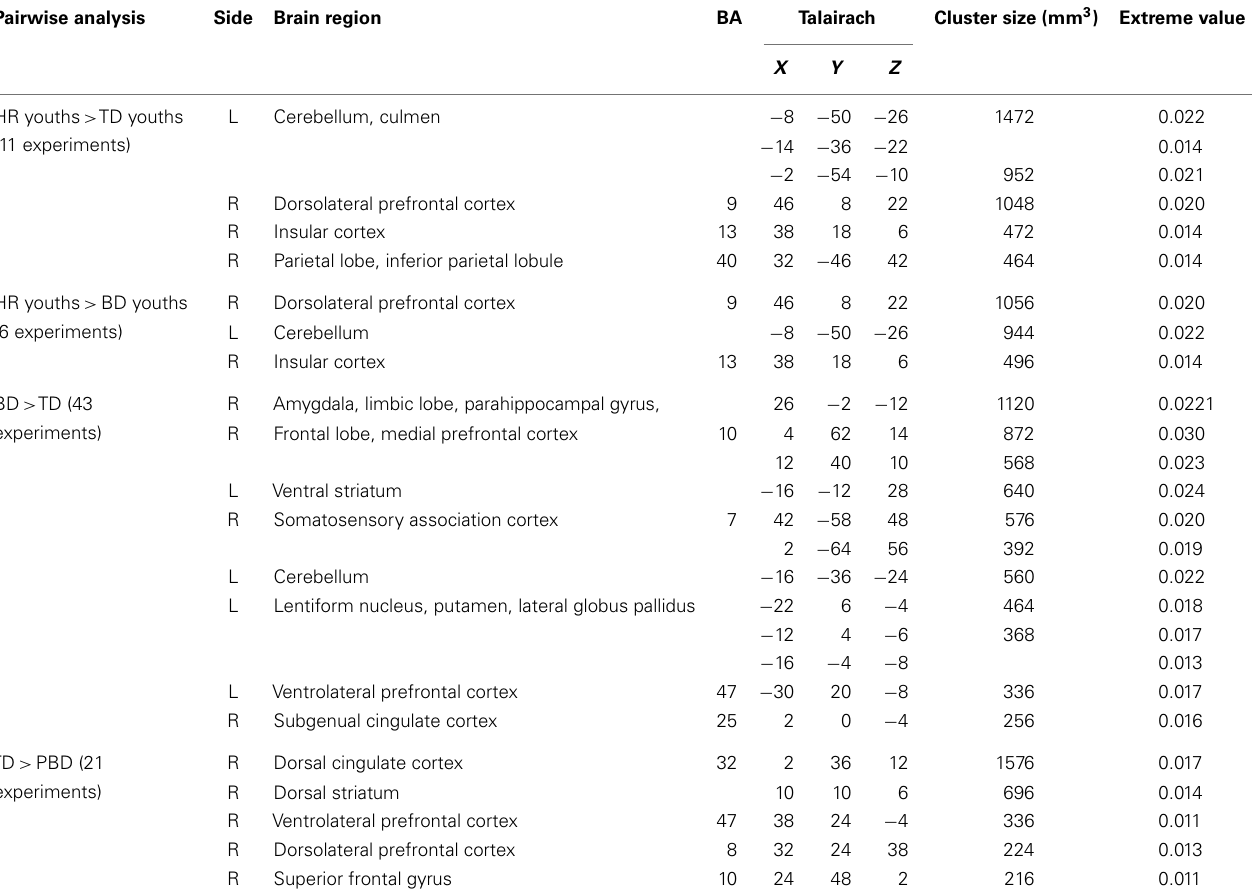
Table 2 |Activation likelihood estimation (ALE) meta-analysis findings for fMRI studies comparing pediatric bipolar disorder (PBD) patients, participants with a high risk (HR) for PBD, and typically developing (TD) children